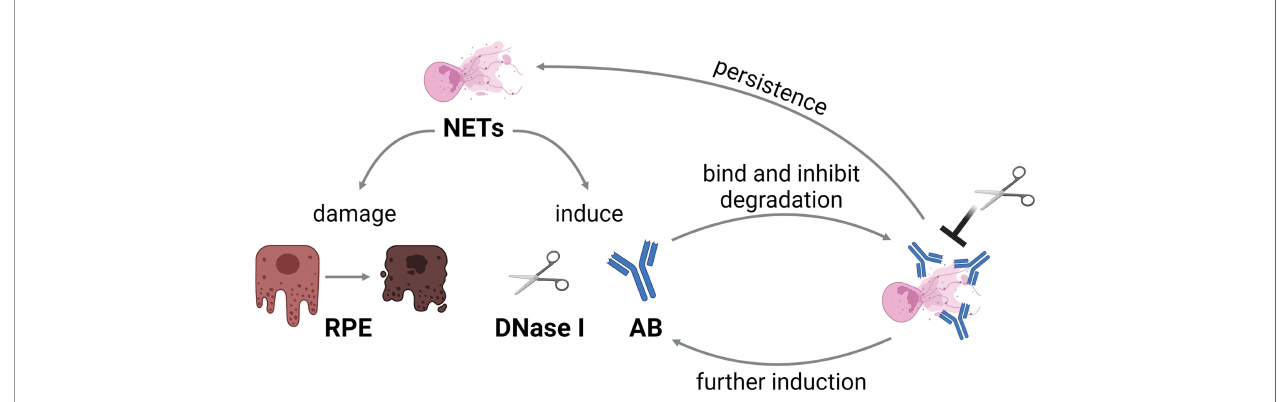
FIGURE 8 | Hypothesis of the vicious circle of NETs and autoantibodies in ERU. NETs induce DNase I and autoantibody production, and furthermore damage the retinal pigment epithelium (RPE). As the autoantibodies bind to NETs, degradation by DNases is impeded. This leads to persistence of NETs, and therefore further induction of autoantibodies, resulting in a vicious circle. The graphic was constructed with